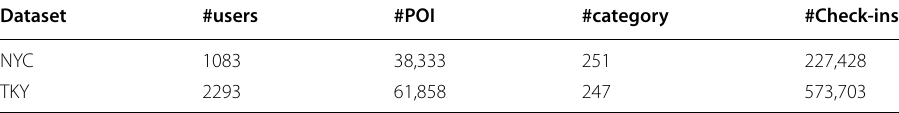
Table 1 Statistics of datasets